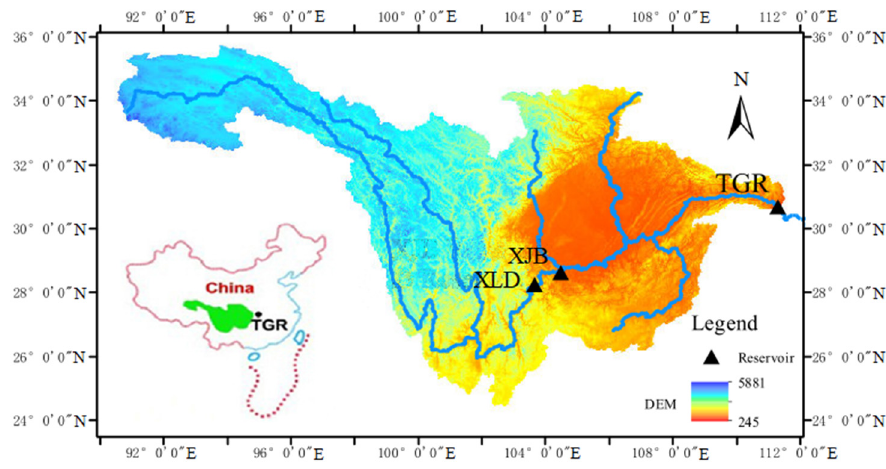
Figure 8. Location of XLD and XJB cascade reservoirs.